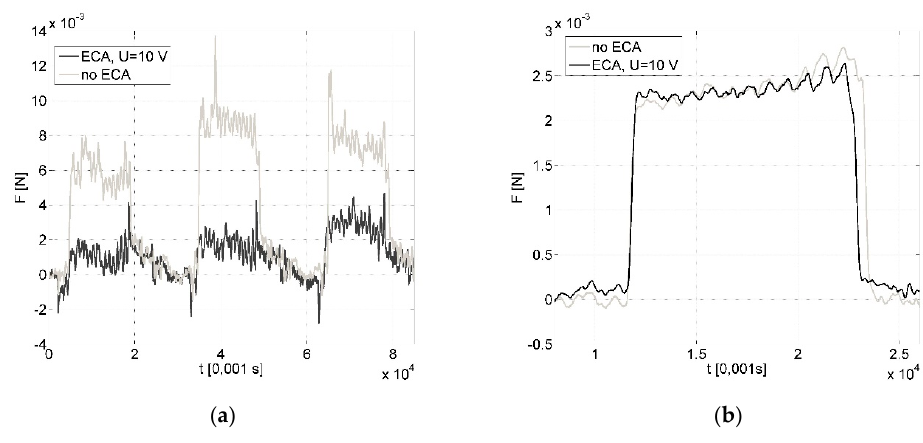
Figure 2. Relation of force sensor load during cutting with the following parameters: feed rate f = 3 µm/rev, cutting speed: V c = 80 m/min; depth of cut a p = 1 µm ( a ) and a p = 10 µm ( b ), ECA in variant A .